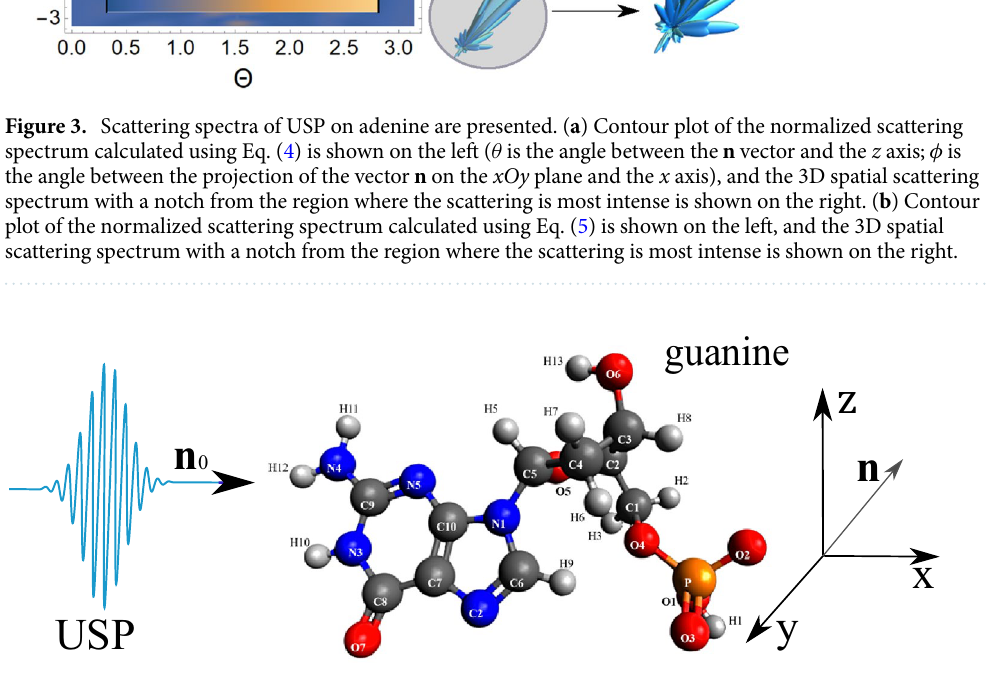
Figure 4. The guanine on which the USP falls is represented, as well as the chosen coordinate system. The calculation was performed in the spatial orientation of the guanine in relation to the USP in the chosen coordinate system shown in this